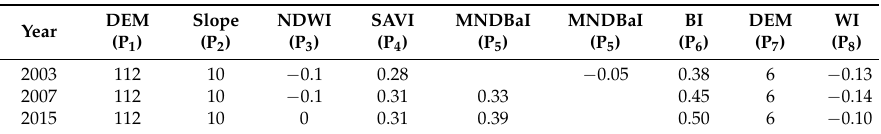
Table 2. Parameters of feature-based approach of decision tree classification derived from the images in